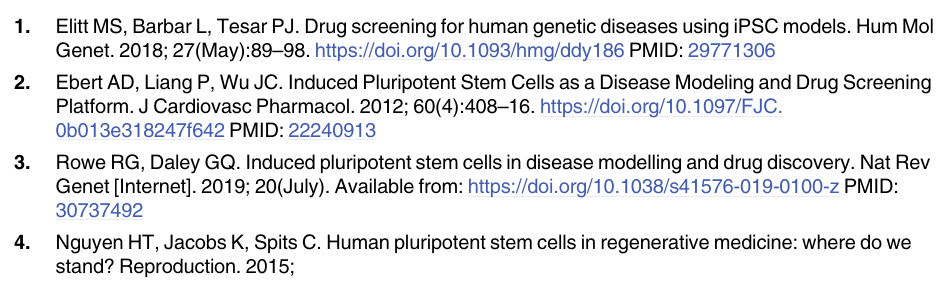
S9 Fig. Entropy score captures CM maturation-related gene expression trends in one-time- point datasets. Gene trends across entropy score, as in Fig 3C , are plotted for A. 10x Chro- mium heart dataset, B. Goodyer et al., and C. Duan et al. (TIFF) S1 Table. In vivo datasets used for this study (TIFF) S2 Table. PSC-CM and iCM datasets used for this study (TIFF) S1 Text. Appendix for all datasets analyzed in this study